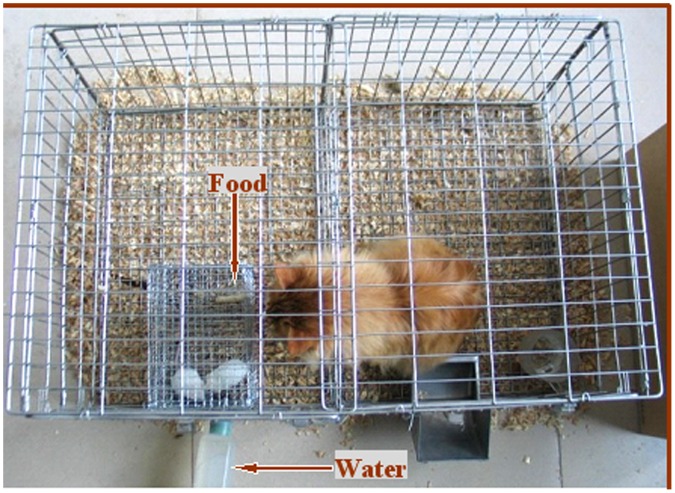
The cage-in-cage system used for the predator stress procedure, which consists of a large outer cage for the predator (cat) and a small inner cage for the prey (mouse).Both cages were made of steel-wire mesh; while the large cage measured 100 cm in length, 50 cm in width and 40 cm in height, the small cage measured 19 cm in length, 13 cm in width and 12 cm in height. The prey cage was fixed in such a position inside the predator cage that the cat and the mouse could see each other clearly from at least three sides.